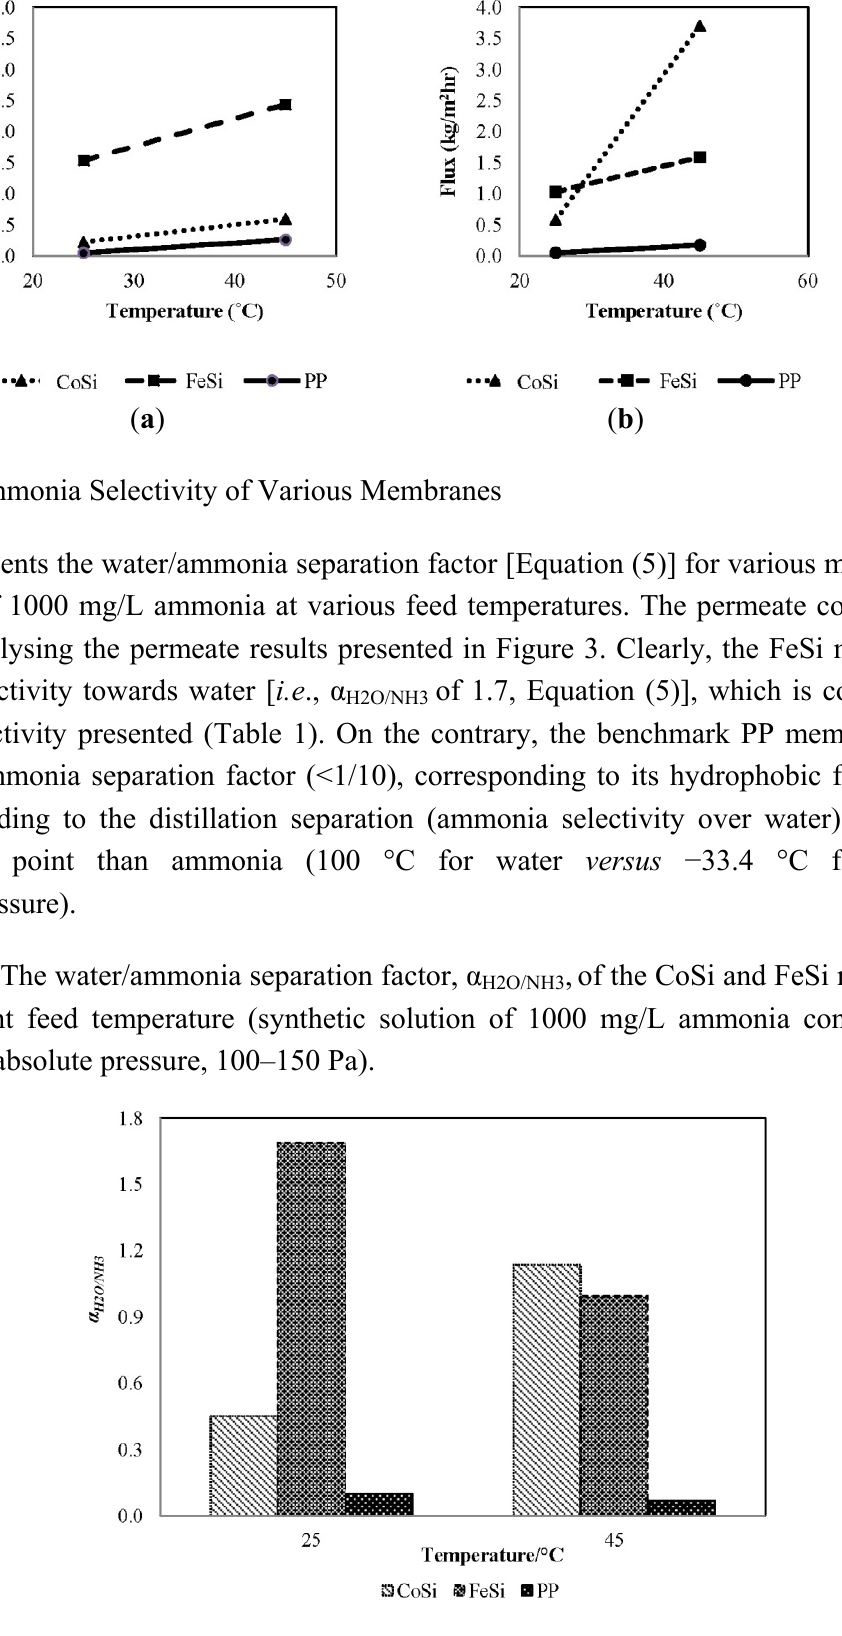
Figure 3. The effect of feed temperature on the total permeation flux of various membranes using synthetic feed solutions (permeate absolute pressure 100–150 Pa):